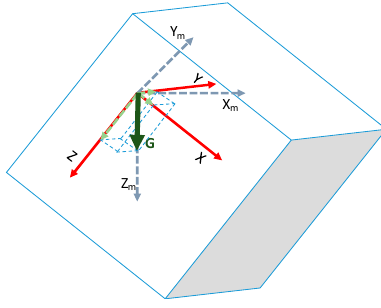
Figure 15. The fixed magnetometer and the acceleration axes.